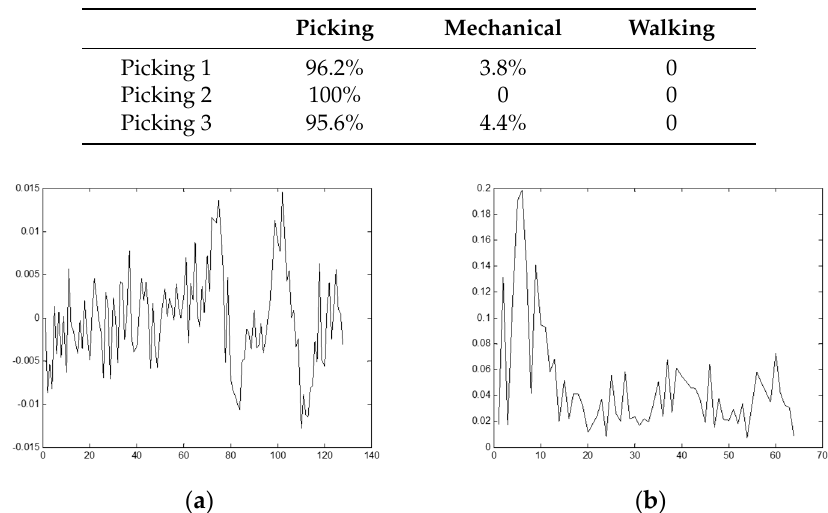
Figure 22. Picking signal recognized as walking signal. ( a ) Time domain; ( b ) Frequency domain; Table 4. The identification rate of picking signals.